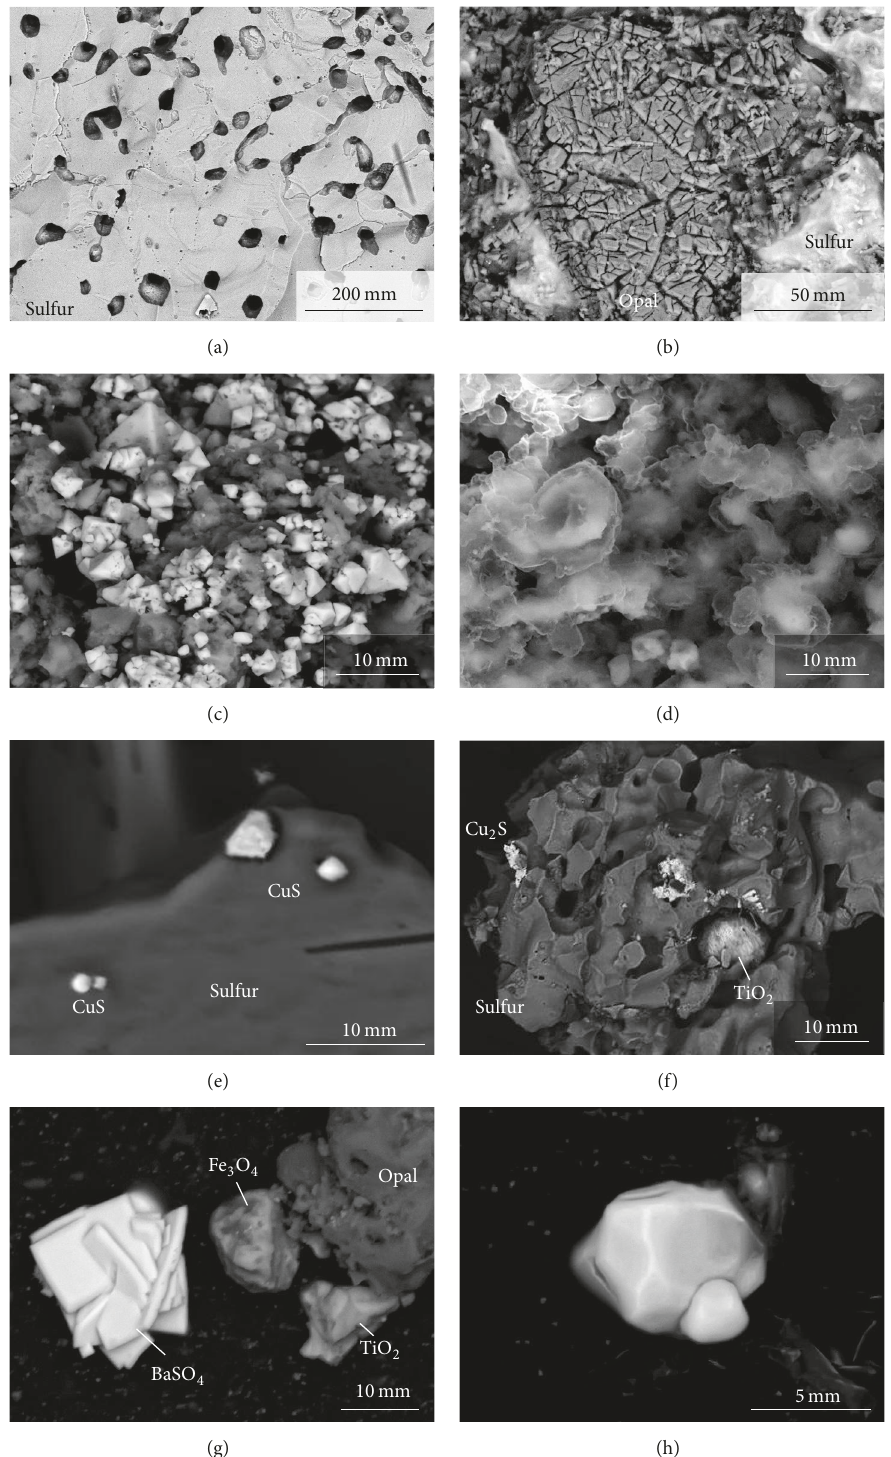
Figure 6: Major and rare phases from fumarolic incrustations of Ebeko volcano. (a) Molten and solidified sulfur with “cheese texture.” (b) Opal with contraction cracks surrounded by sulfur. (c) Octahedral pyrite crystals mixed with silicate particles. (d) Aggregate of sassolite (H 3 BO 3 ) crystals. (e) Covellite (CuS) crystals on sulfur. (f) Chalcocite (Cu 2 S) aggregates and a particle of TiO 2 (rutile?) inside a pore. (g) Barite, magnetite, rutile, and opal aggregates extracted from sulfur. (h) Euhedral crystals of scheelite. SEM BSE